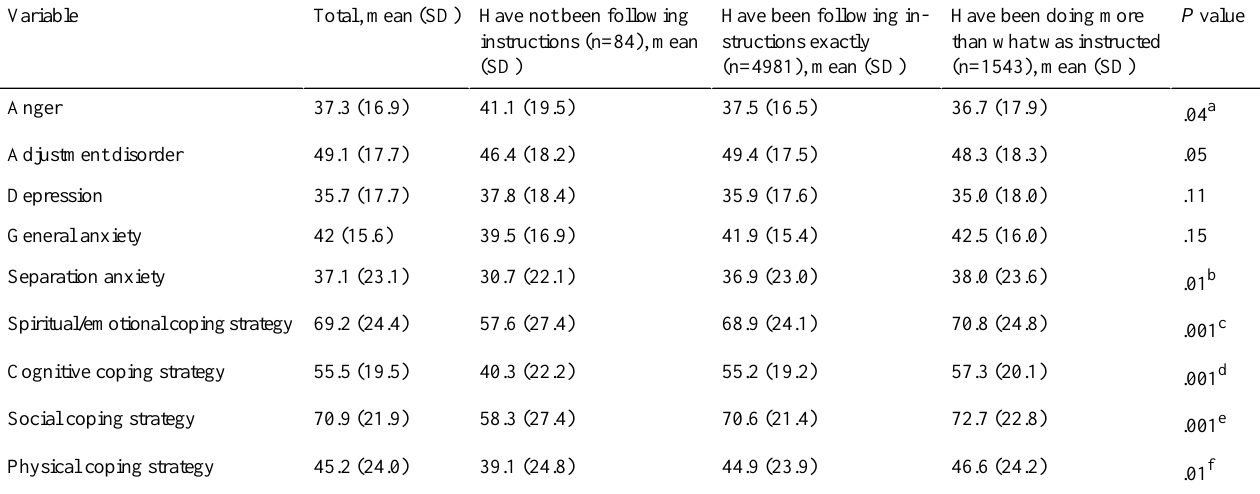
Table 6. The difference in the mean score of selected final psychological diagnoses and coping strategies used across the 3 levels of compliance with the official regulations among children and adolescents during home isolation and social distancing due to the COVID-19 pandemic in Qatar in 2020